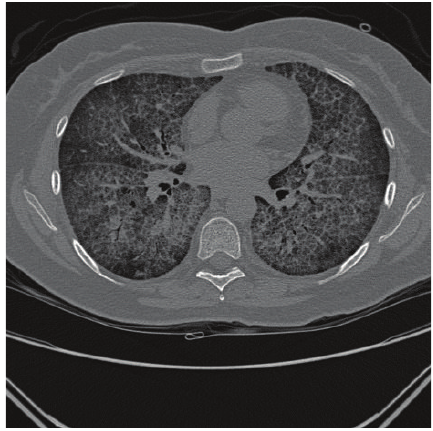
Figure 2: CT of the thorax depicting diffuse bilateral ground- glass opacities with intralobular septal thickening; the findings are reported by the radiologist to be a crazy paving pattern.